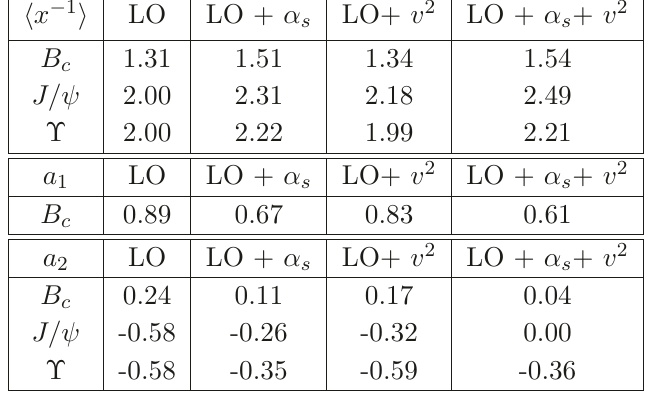
Table 4 . Inverse moments and Gegenbauer moments of LCDAs for the B c , J/ψ and Υ states, q 2 the used here are deduced by potential model. Leading-order results, one-loop QCD radiative h i corrections, relativistic corrections and the total results are shown, respectively.